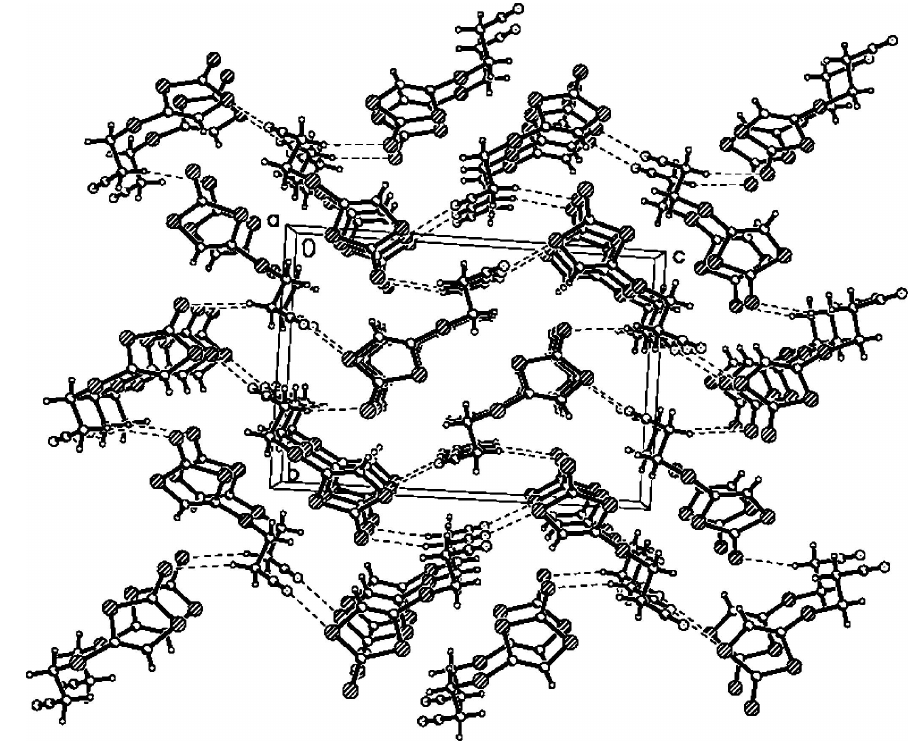
The molecular structure of the title compound with ellipsoids drawn at the 30% probability level.